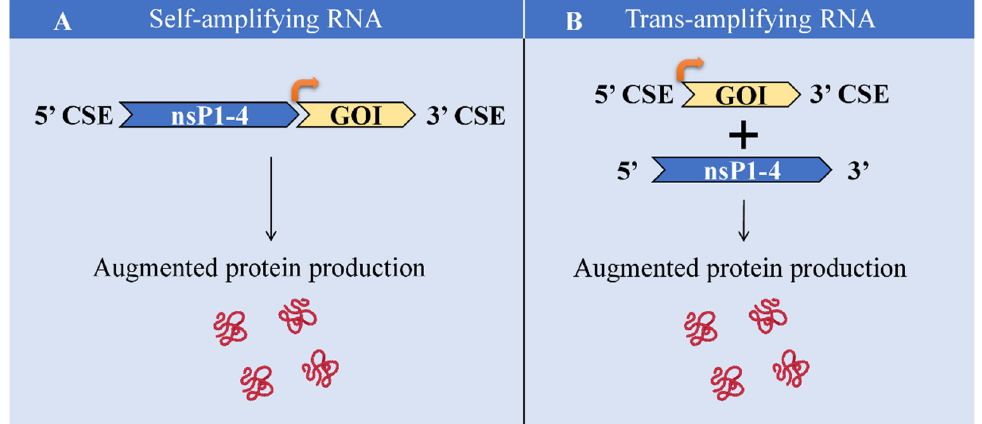
Figure 4. Comparison of saRNA and taRNA. ( A ) saRNA is a single large RNA molecule encoding nsP1-4 and GOI. As a result, protein of interest is produced in augmented levels. ( B ) taRNA represents two RNA molecules encoding GOI and nsP1-4 separately. As a result, protein of interest is produced in augmented levels. CSE, conserved sequence elements; nsP1-4, non-structural protein 1-4; GOI, gene of interest.